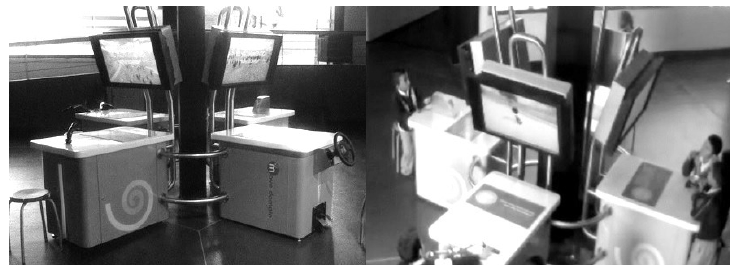
Figure 3. Analyzed interactive museum exhibition